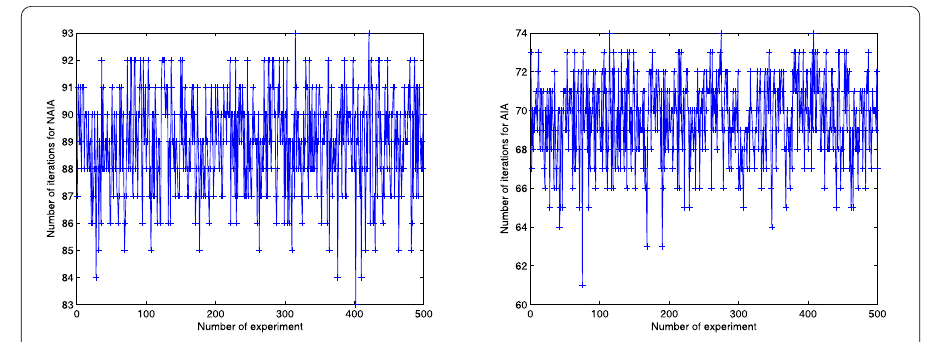
Figure 3 The iterative number of NAIA and AIA for the initial point of Case 3